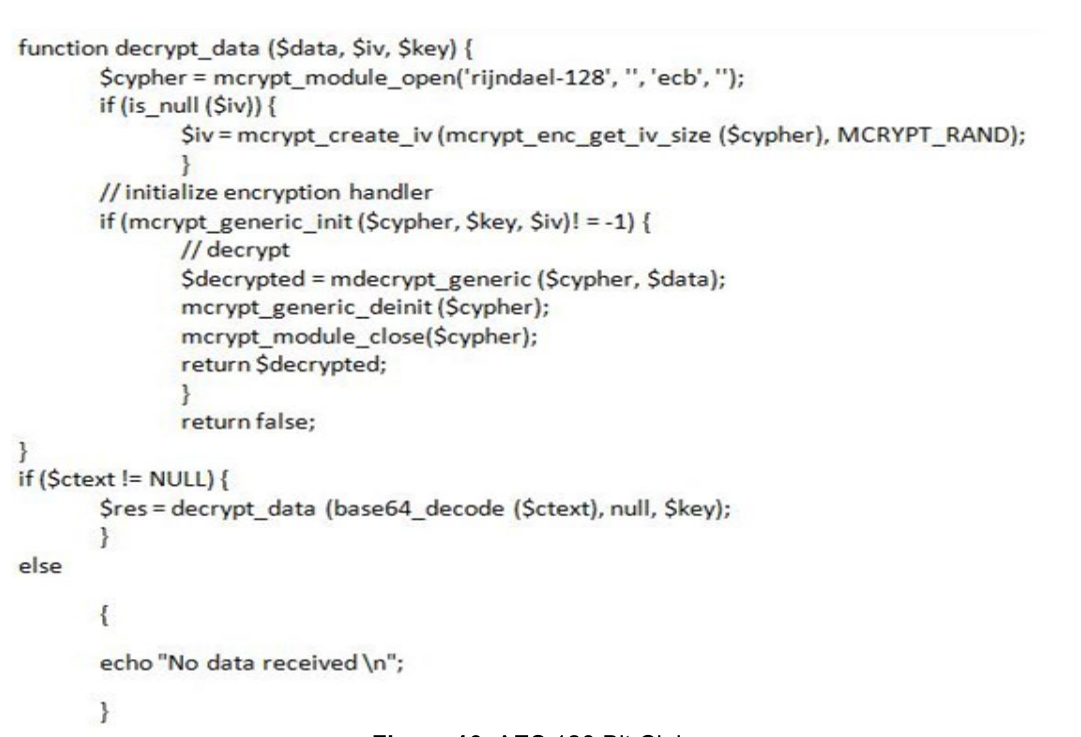
Figure 10. AES 128 Bit Cipher